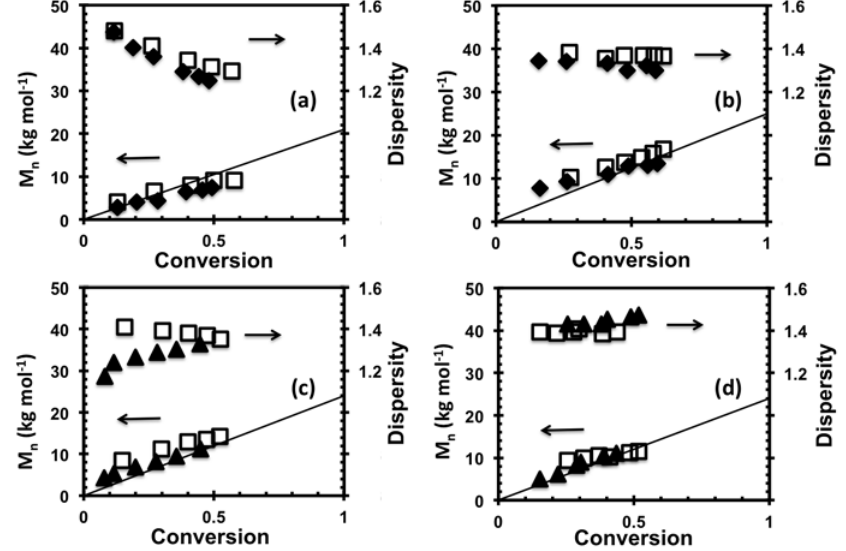
Figure 2. The number average molecular weight ( ), determined by gel permeation chromatography (GPC) relative to poly(methyl methacrylate) standards in chloroform ( a ) or 𝑀� 𝑛 N,N-dimethylformamide (DMF) ( b , c and d ) and dispersity ( ) versus conversion for various NLAM/X (X = controlling co-monomer) random copolymerization initiated by 𝑀� 𝑤 𝑀� 𝑛 ⁄ BlocBuilder ® in 1,4 dioxane solution at 90 C: ( a ) NLAM/AcOST-5 ( □ ), NLAM/AcOST-10 ( ■ ); ( b ) NLAM/ST-5 ( □ ), NLAM/ST-10 ( ■ ); ( c ) NLAM/VN-5 ( □ ), 𝑀� 𝑤 𝑀� 𝑛 ⁄ NLAM/VN-10 ( ▲ ); ( d ) NLAM/PFS-5 ( □ ), NLAM/PFS-10 ( ▲ ). The straight solid indicates the theoretical versus conversion based on the monomer to initiator ratio for the particular experiment. All characterization of experiments is listed in Table 𝑀� 𝑛